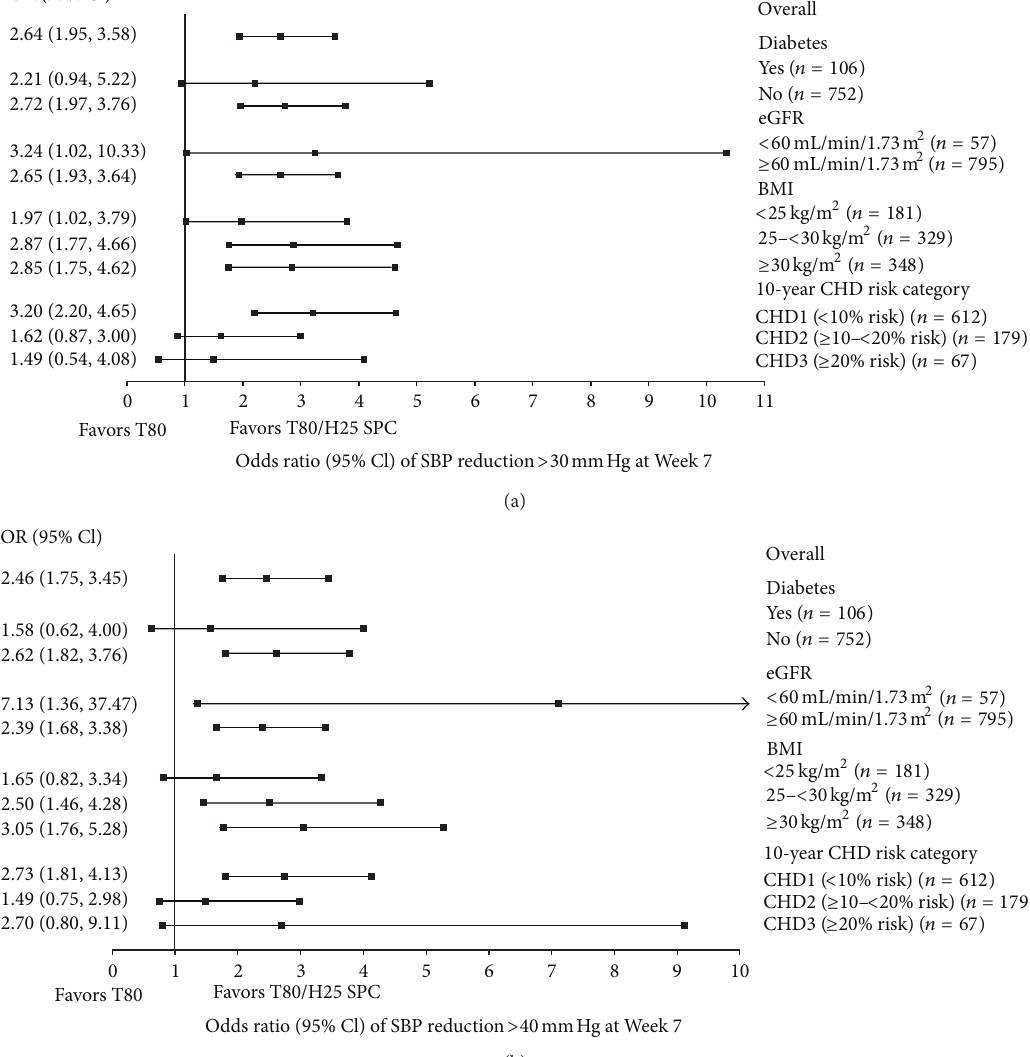
25: 71.3% versus 57.6%; BMI 25– < 30: 73.4% versus 54.8%; BMI ≥ 30: 61.2% versus 47.7%) (Figure 2). A similar pattern was observed for SBP reductions of > 30 mm Hg, which were achieved in a greater proportion of patients receiving SPC T80/H25 across all three BMI categories (Figure